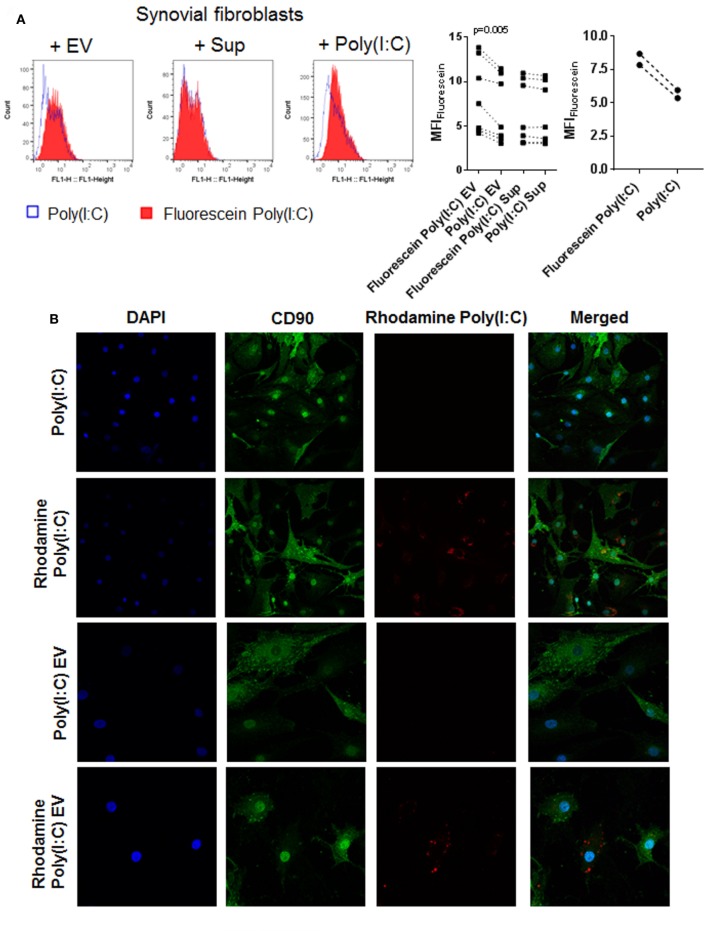
U937 cell derived extracellular vesicles (EV) shuttle Poly(I:C) to synovial fibroblasts. (A) The presence of Fluorescein Poly(I:C) in synovial fibroblasts either cocultured with U937 cell-derived Fluorescein Poly(I:C) EV or Poly(I:C) EV, or treated with supernatants from the last washing step of the respective EV pellets or stimulated with Poly(I:C)/Fluorescein Poly(I:C). Sup were used to control for the contamination with soluble Poly(I:C). Shown are FL1 histogram of fluorescein fluorescence in a representative sample and quantification of changes in median fluorescence intensities (MFI) of synovial fibroblasts upon different treatments. (B) Confocal microscopy on synovial fibroblasts treated with Poly(I:C) or Rhodamine Poly(I:C) or cocultured with U937 cell-derived Poly(I:C) EV or Rhodamine Poly(I:C) EV for 24 h. Nuclei-DAPI (blue), FITC Mouse Anti-Human CD90 (green, fibroblast marker), Rhodamine Poly(I:C) (red). Magnification: 20× [Poly(I:C), Rhodamine Poly(I:C)] and 40× [Poly(I:C) EV, Rhodamine Poly(I:C) EV]. Statistics: (A) one way ANOVA with Sidak’s multiple comparison test and Geisser-Greenhouse correction for unequal sphericity.